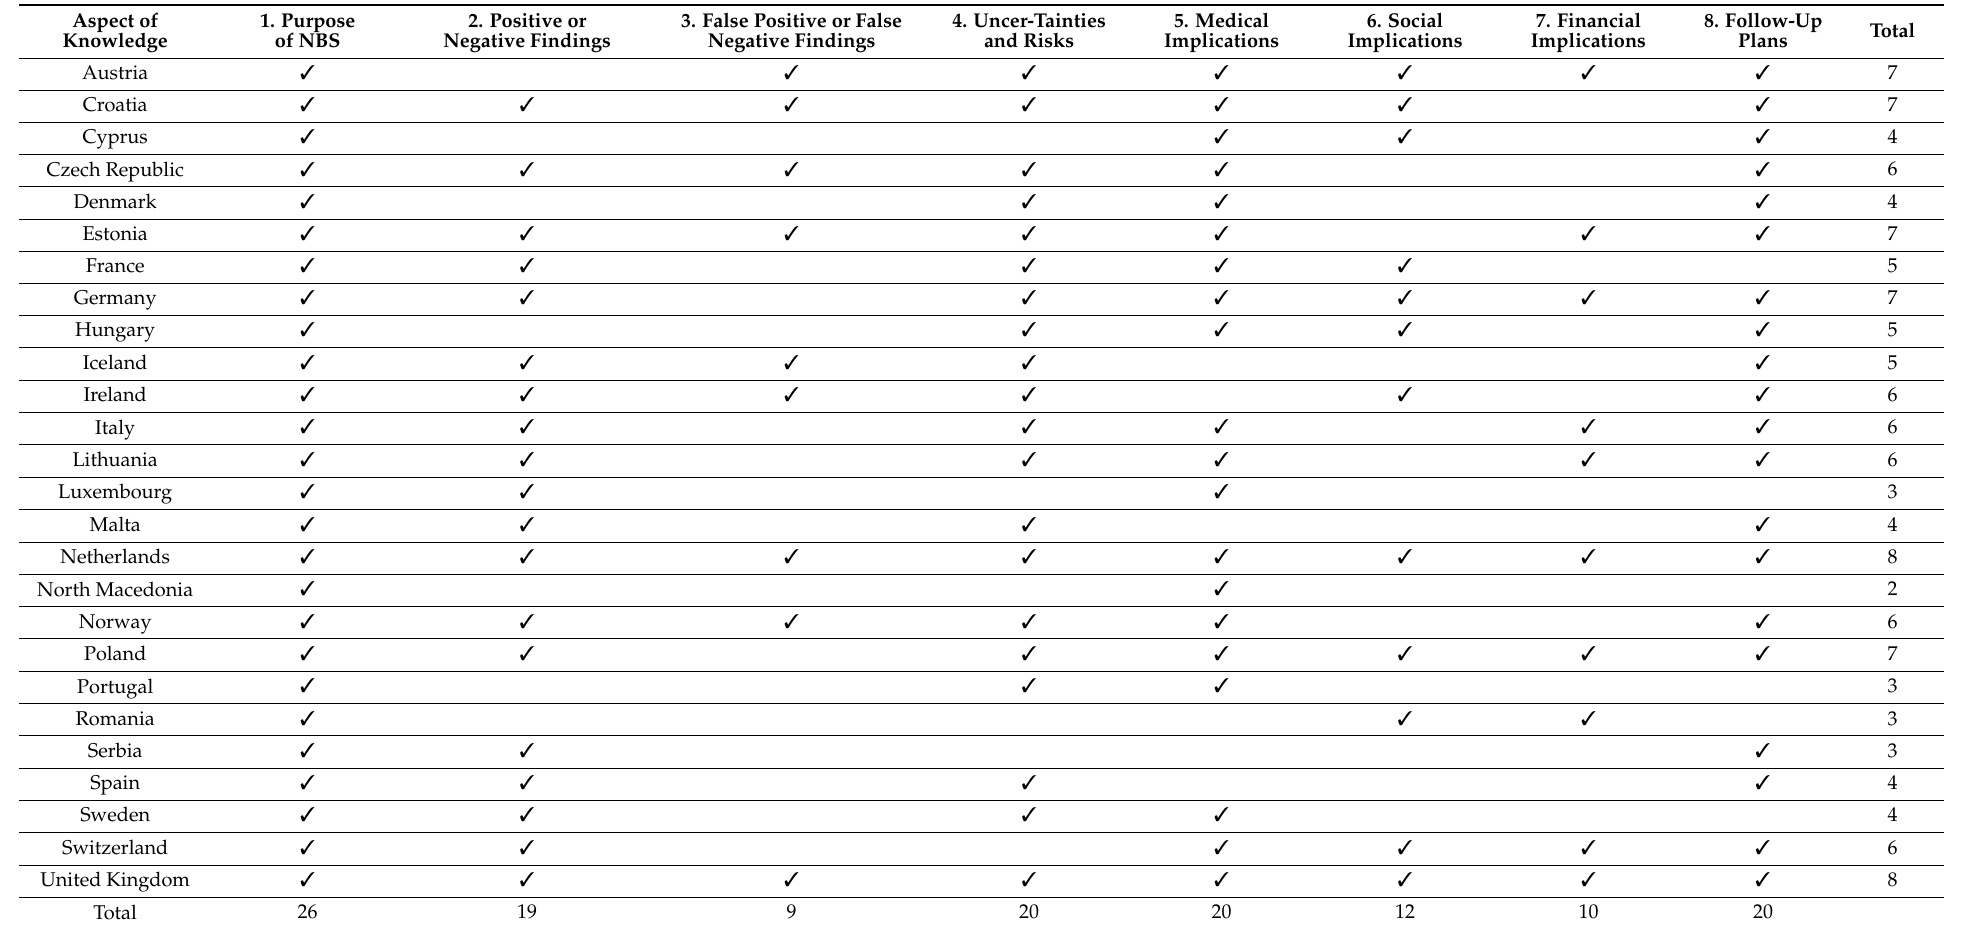
Table 3. Key results of all knowledge aspects per country 1